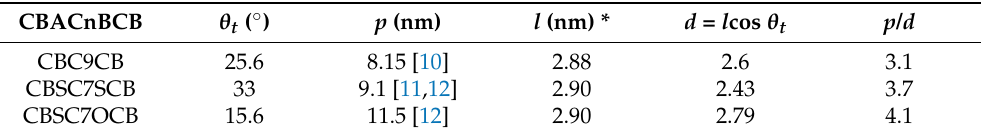
Figure 6. Proposed hypothetical arrangement of the thioether dimers in the twist–bend nematic phase. The helix pitch was computed as p = 2 π / q , where q is the wave vector. Table 2. Summary of the determined molecular parameters: the length of the molecule ( l ), the tilt angle ( θ t ), the helix pitch ( p ), the effective length of the molecule ( d ), and the number of molecules per helix pitch ( p / d